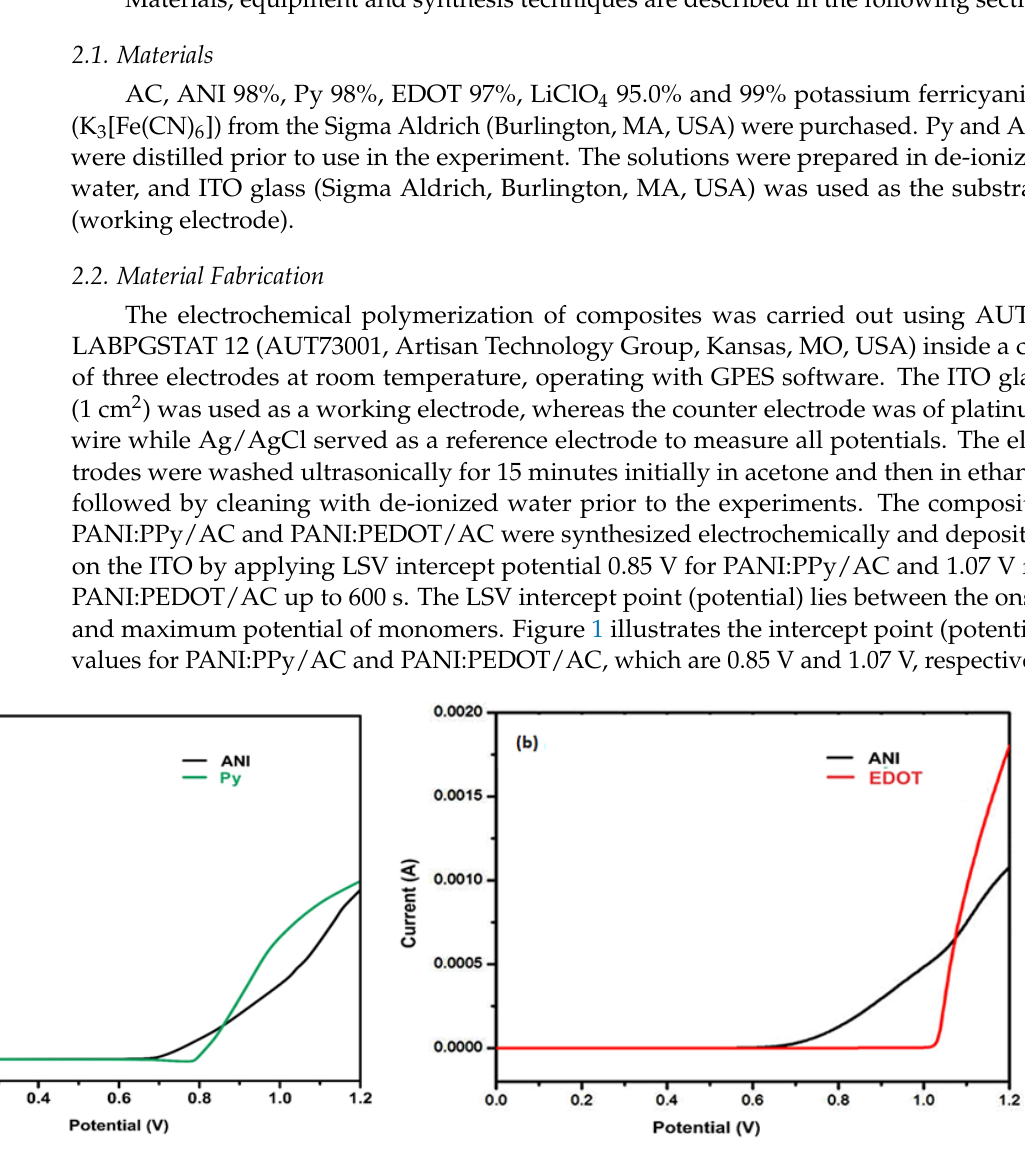
Figure 1. LSV curves ( a ) 10 mM Py and 10 mM ANI ( b ) 10 mM ANI and 10 mM EDOT in presence of 0.1 M LiClO 4 on ITO, at potential range 0 to 1.2 V.